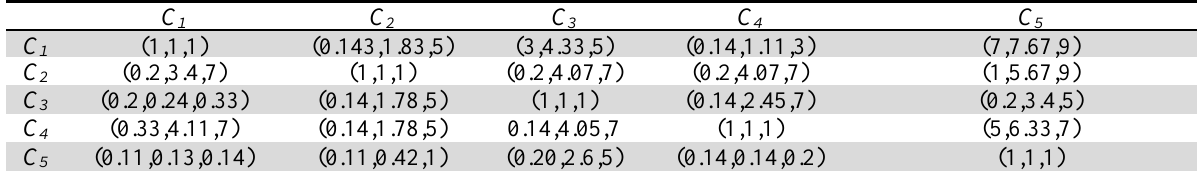
Aggregated fuzzy pair-wise comparison